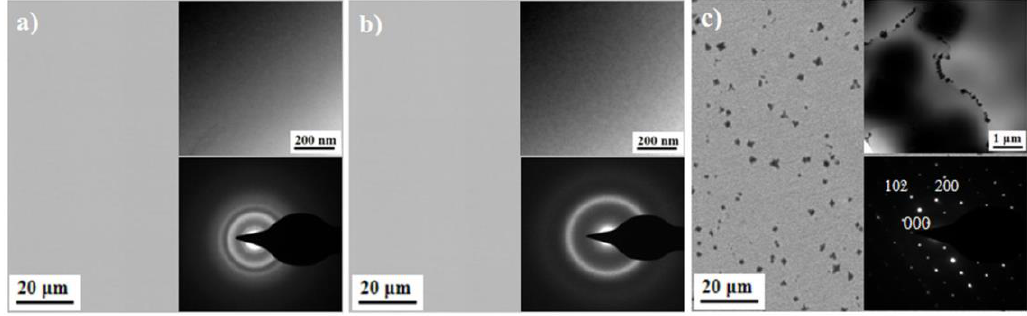
Figure 3. SEM and TEM images, together with the selected area electron diffraction (SAED) patterns of the samples after creep tests at 680 K with different applied stresses: ( a ) 50 MPa; ( b ) 100 MPa; and ( c ) 180 MPa.